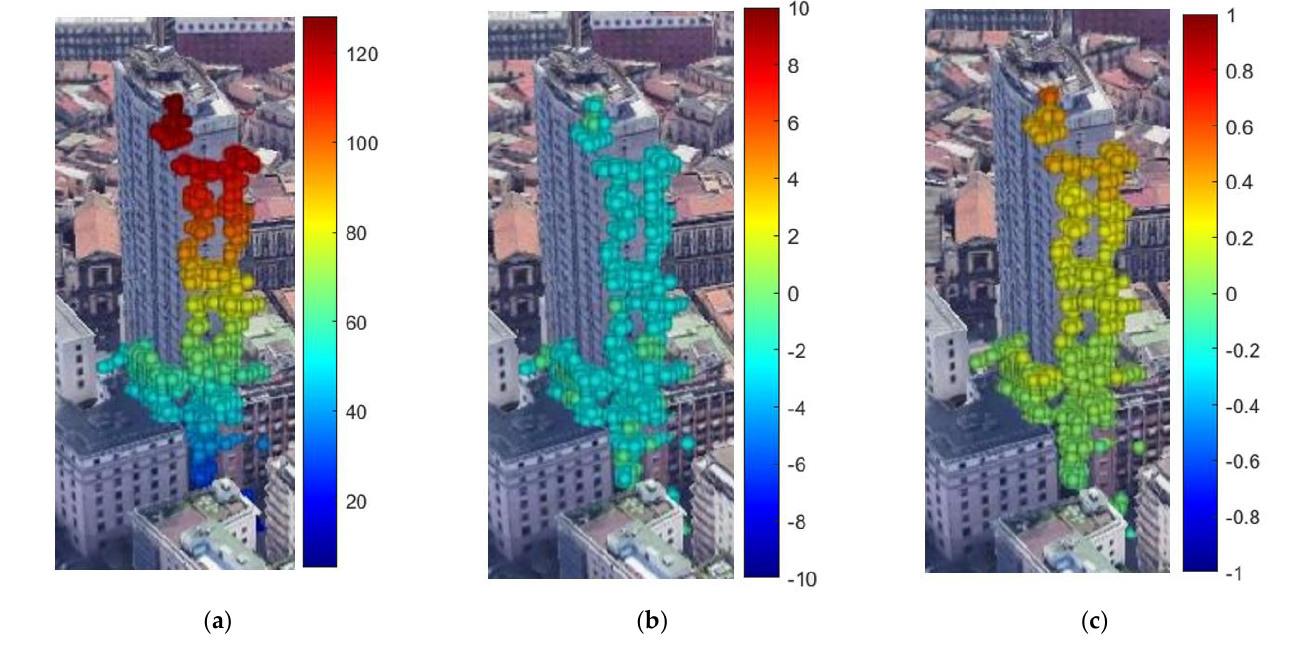
Figure 10. Jolly Hotel test site: ( a ) points detected using MGLRT with a 3 × 3 patch, positioned in the optical 3D image, with a colorization corresponding to the height (m), ( b ) to the linear deformation velocity (mm/year), and ( c ) to the thermal dilation coefficient (mm/°C).